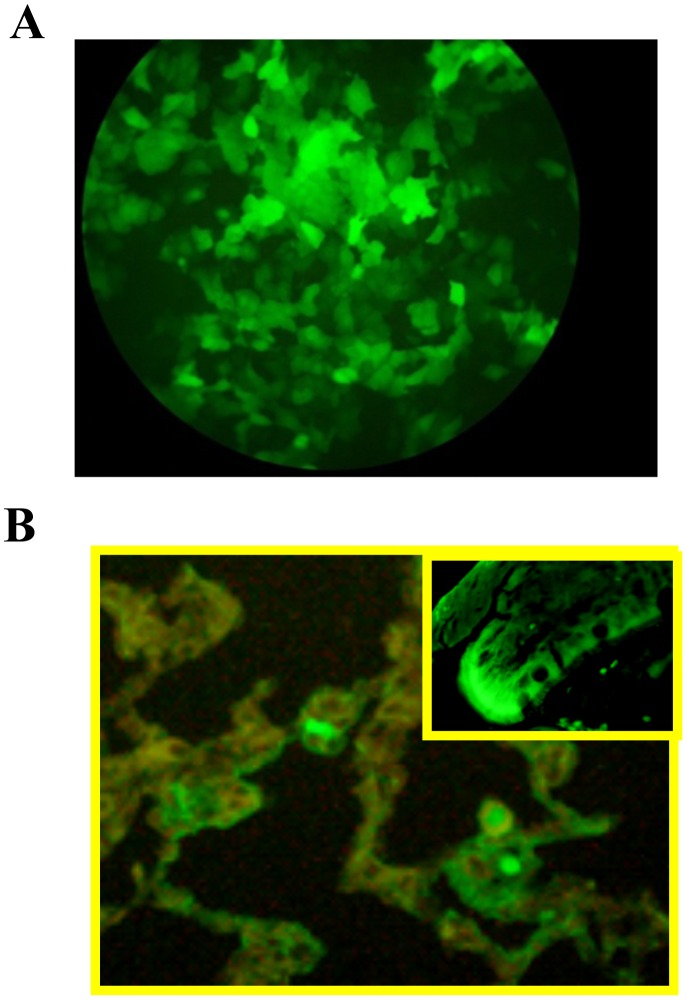
Expression of EGFP from rhPIV2/EGFP.
A. HaCat cells were infected with rhPIV2/EGFP at an MOI of 0.5. Three days after, EGFP was clearly visualized using a fluorescence microscopy (x100). B. The rhPIV2/EGFP (5×106 TCID50) were administered to a wild type BALB/c mice intranasally EGFP was visualized clearly in the airway epithelial cells 4 days after administration (x200, upper right box, x400).